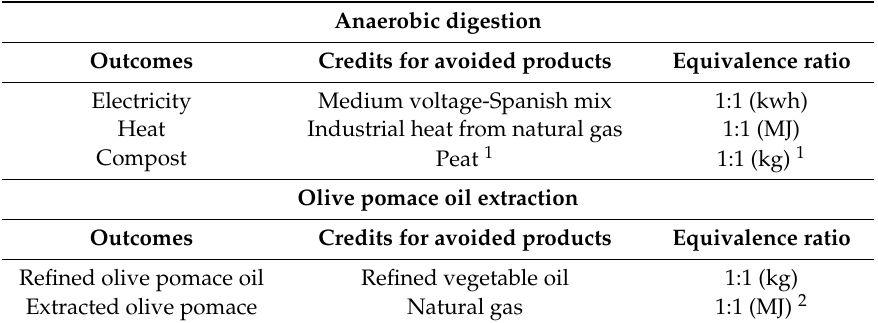
Table 3. Credits associated with avoided products for each valorization